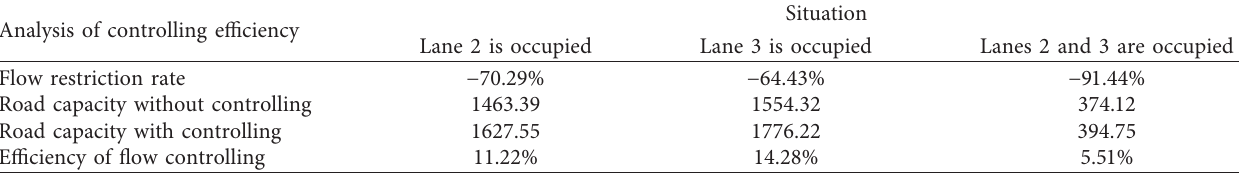
Table 3: Analysis of traffic flow control results under accidental